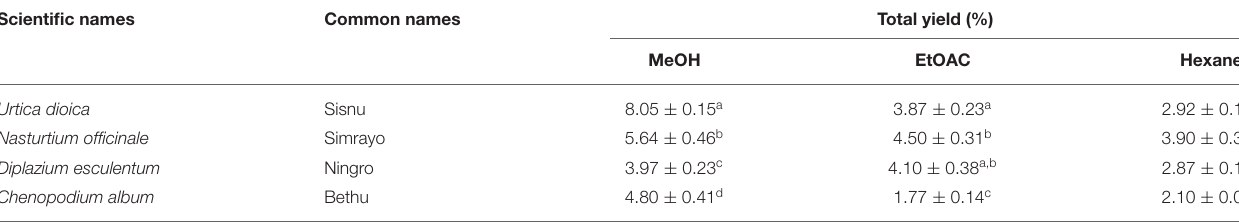
TABLE 2 | Scientific nomenclature and extract yield of selected leafy greens of Sikkim Himalayan Region. Scientific names